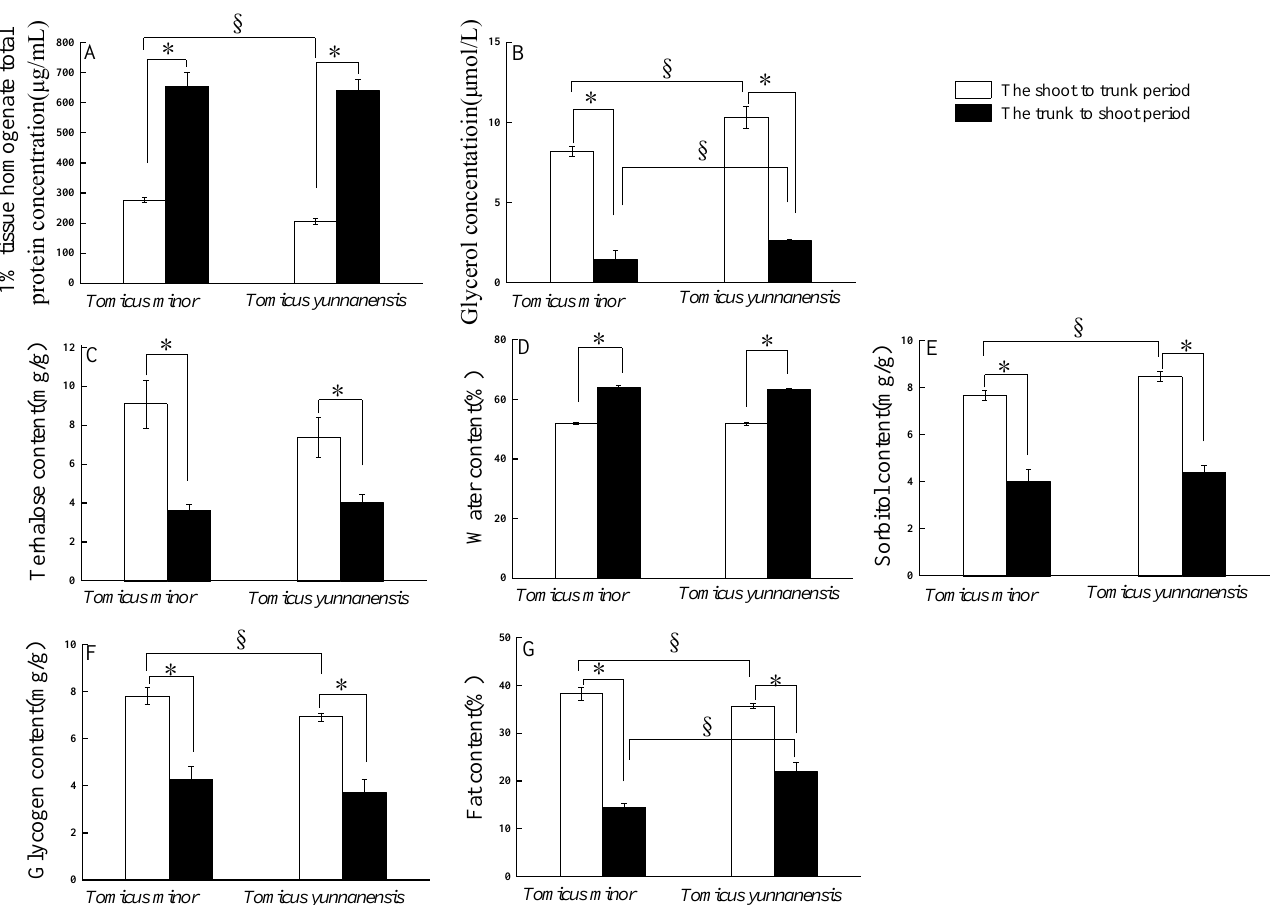
Figure 2. Contents of substances in adults of two Tomicus species at two periods. Note: protein; ( A ), glycerol; ( B ), trehalose; ( C ), water; ( D ), sorbitol; ( E ), glycogen; ( F ), fat ( G ). The data were mean ± S.E, * in the same plot indicated that there were significant differences in different stages of the same species of Tomicus ( p < 0.05), and § in the same plot indicated that there were significant differences in the two Tomicus species ( p < 0.05) at the same period.